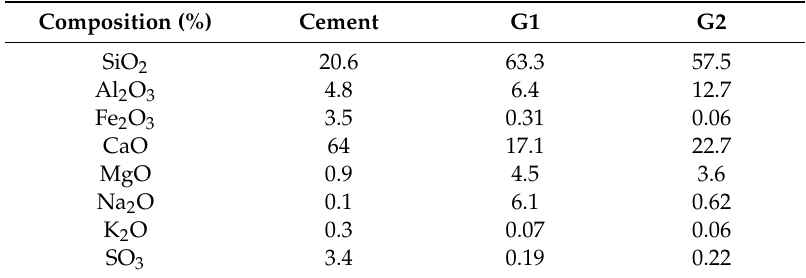
Table 2. Chemical compositions of cement, G1, and